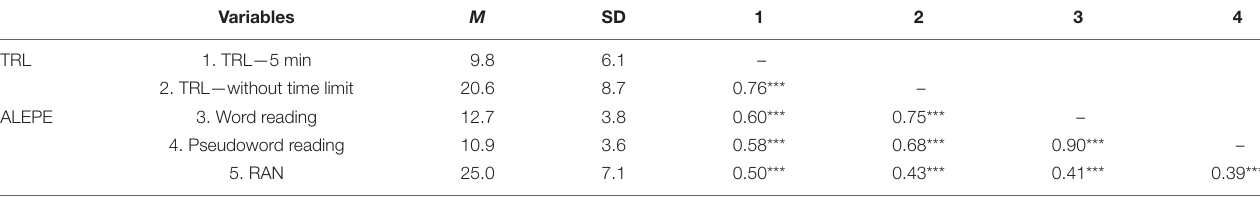
TABLE 2 | Means, standard deviations, and